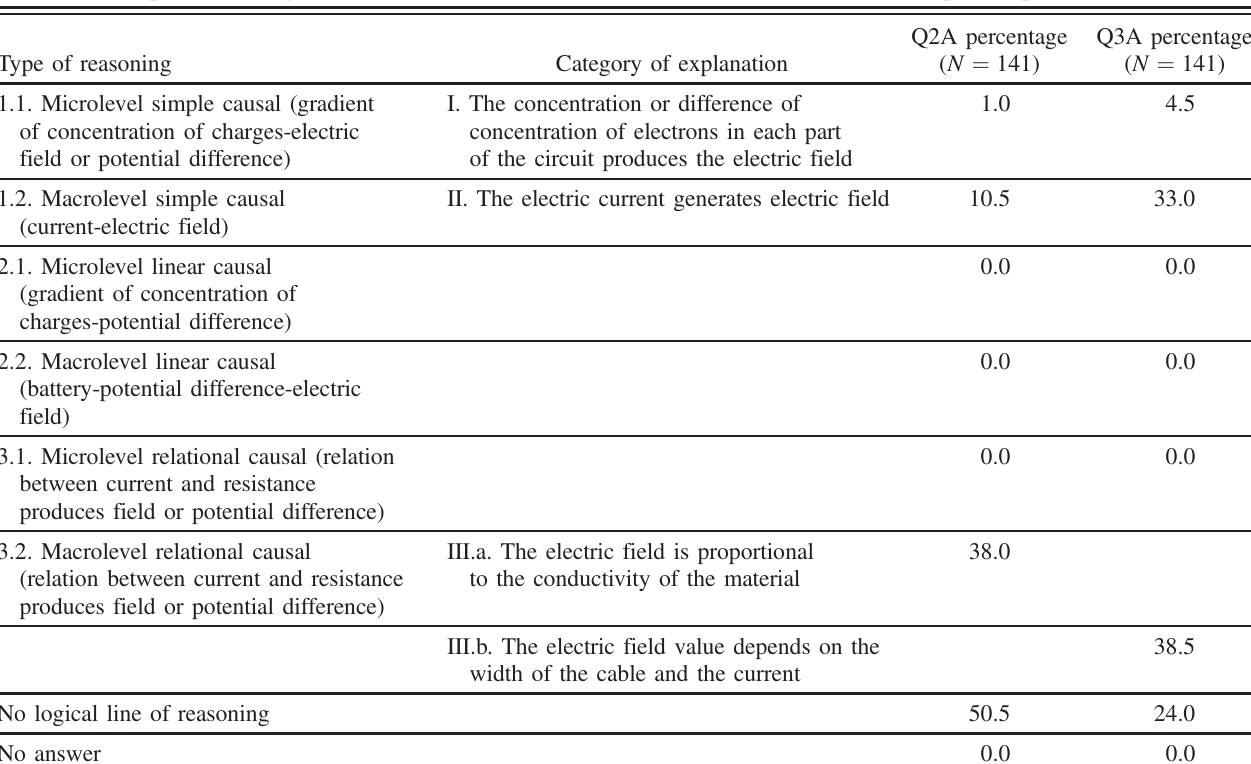
TABLE II. Explanation categories to the relations between current and electric field in the first part of questions Q2A and Q3A. Type of